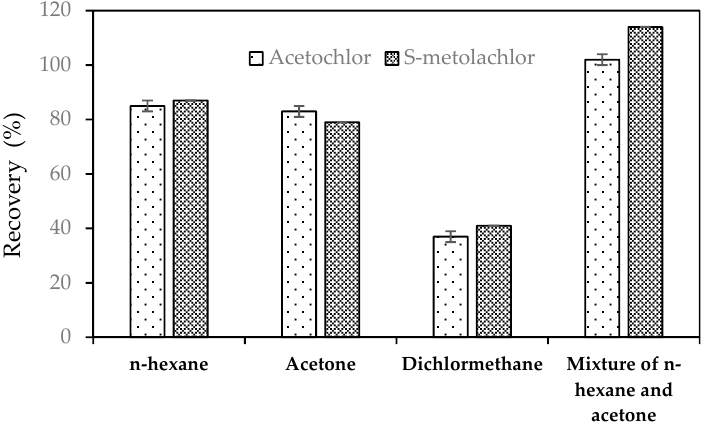
Figure 3. Influence of solvent type on the acetochlor and s-metolachlor extraction procedure.